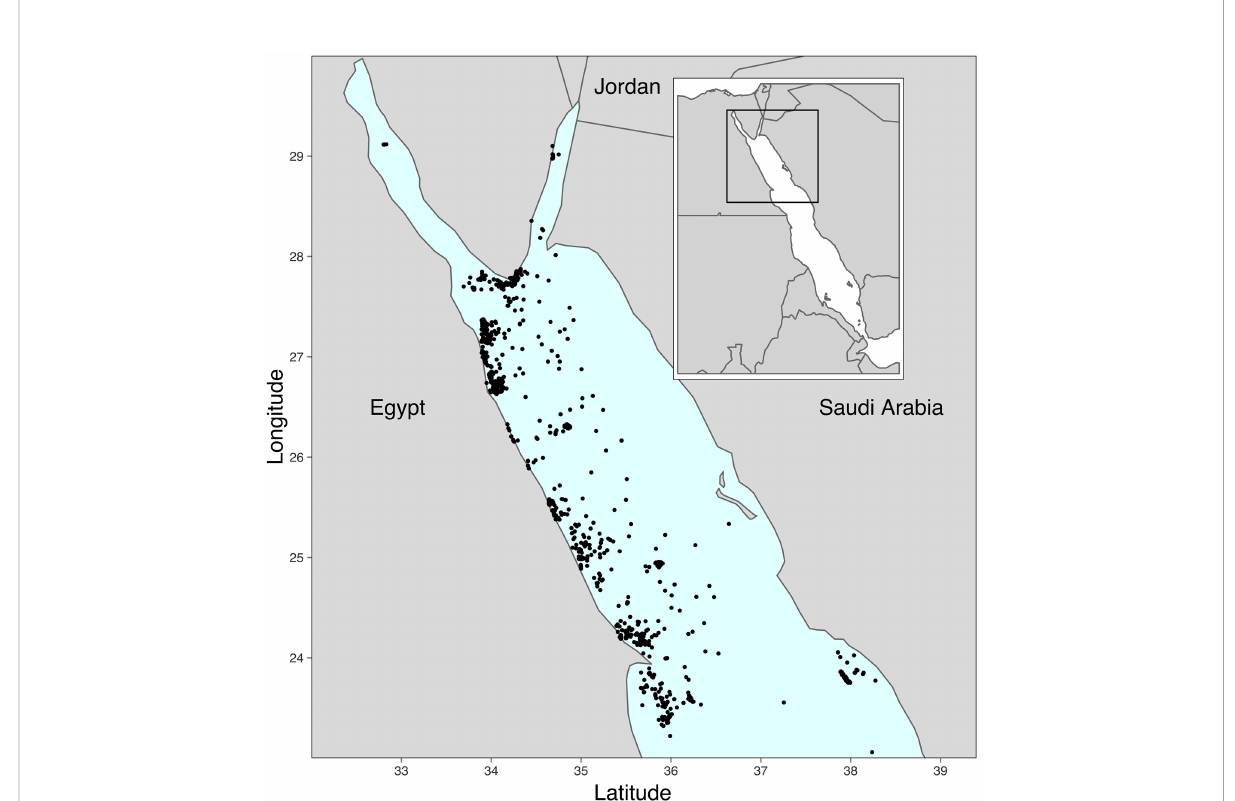
FIGURE 2 Map of the study region with fi nal selection of dives used in analyses. Inset map shows wider contextual area, with area of interest highlighted with a